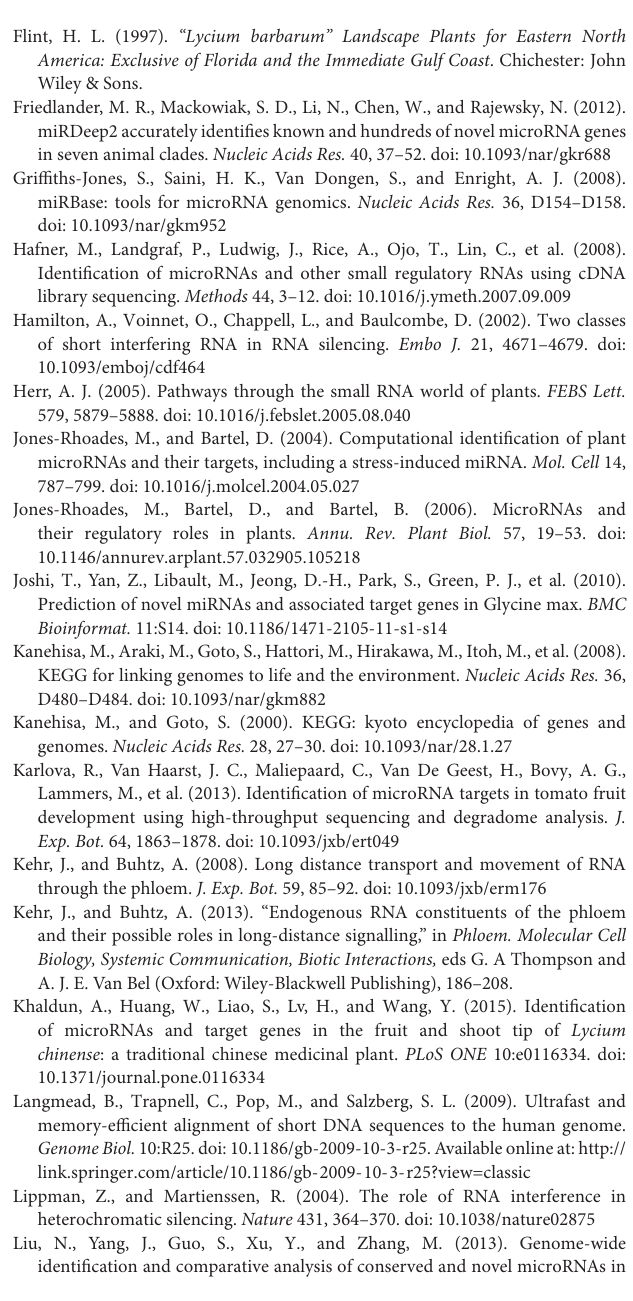
Table S2 | Statistics of evolutionary known and novel miRNAs in grafted and control tomato plants. Table S3 | Details of differentially expressed evolutionary known and novel miRNAs in grafted and control tomato plants.